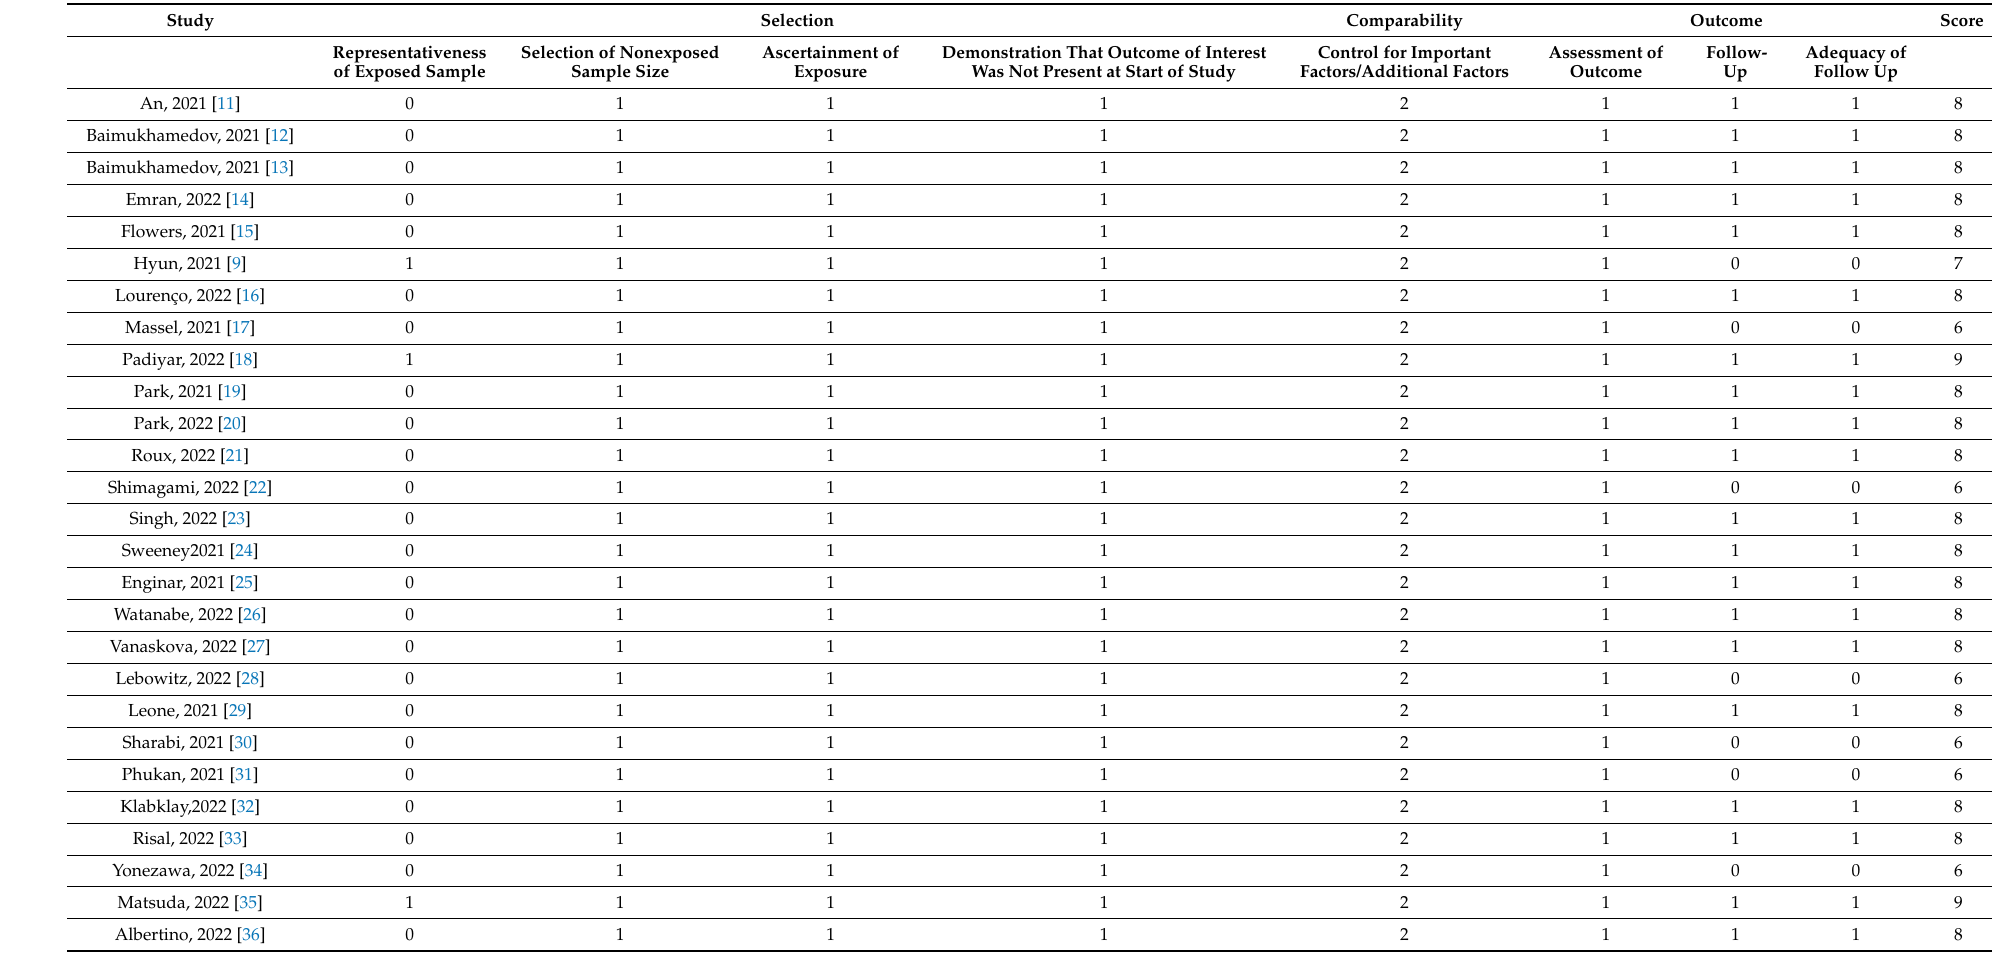
Table 4. Quality assessment of the included